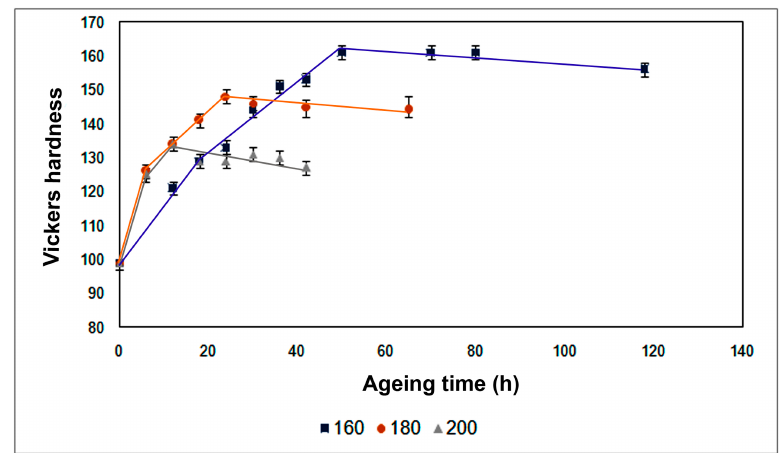
Figure 10. Hardness profiles of the specimens treated at 495 °C for 4 h, with ageing treatments at 160, 180, and 200 °C, respectively. Error bars define the distance between the maximum and minimum values vs. the average value.